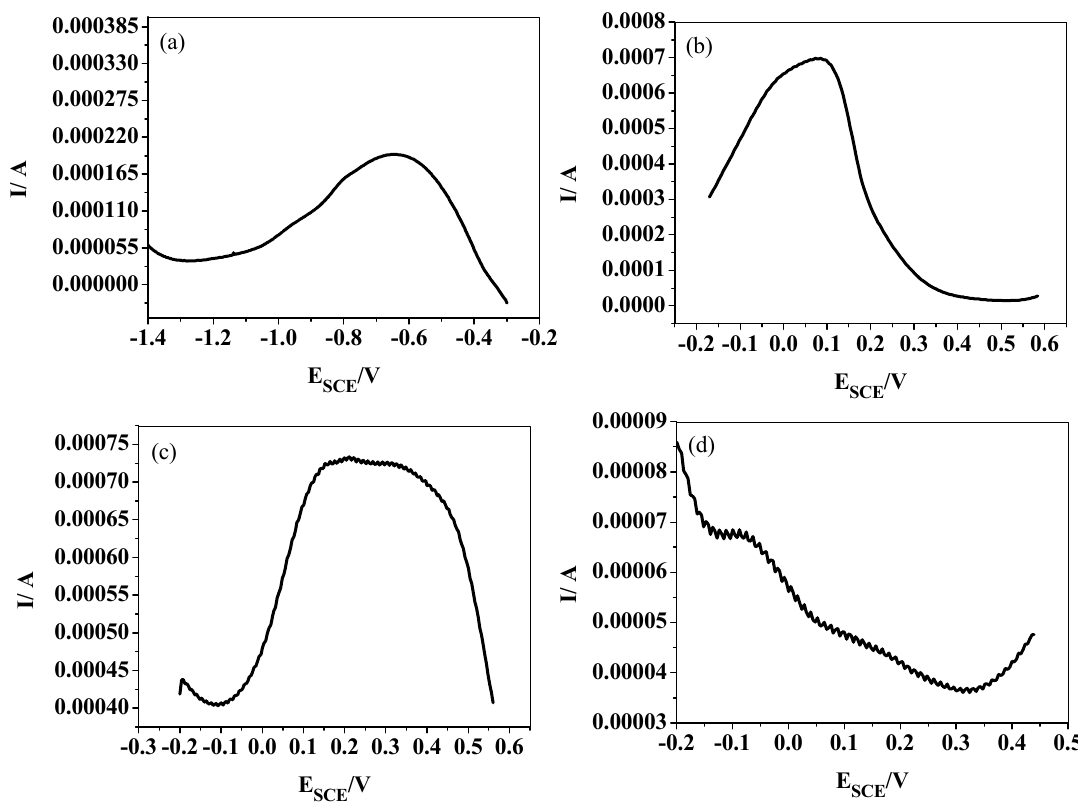
Figure 4. Square wave voltammograms of ( a ) bare, as well as ( b ) PACHA-, ( c ) PANI-, and ( d ) PHA- electrodes in citrate bu ff er of pH 5, containing 1.4 × 10 − 6 M H 2 O 2 coated electrodes in citrate buffer of pH 5, containing 1.4 × 10 − 6 M H 2 O 2 .